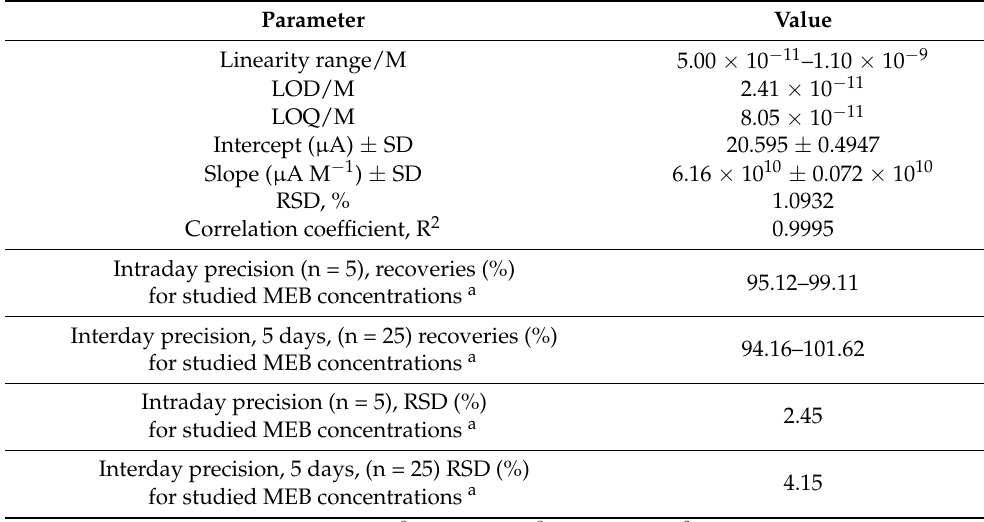
Table 2. Regression data of calibration plot for MEB using Cu 2 ONPs–C@G/PE in 0.1 M phosphate buffer solutions (pH ≈ 8) containing 0.1 M